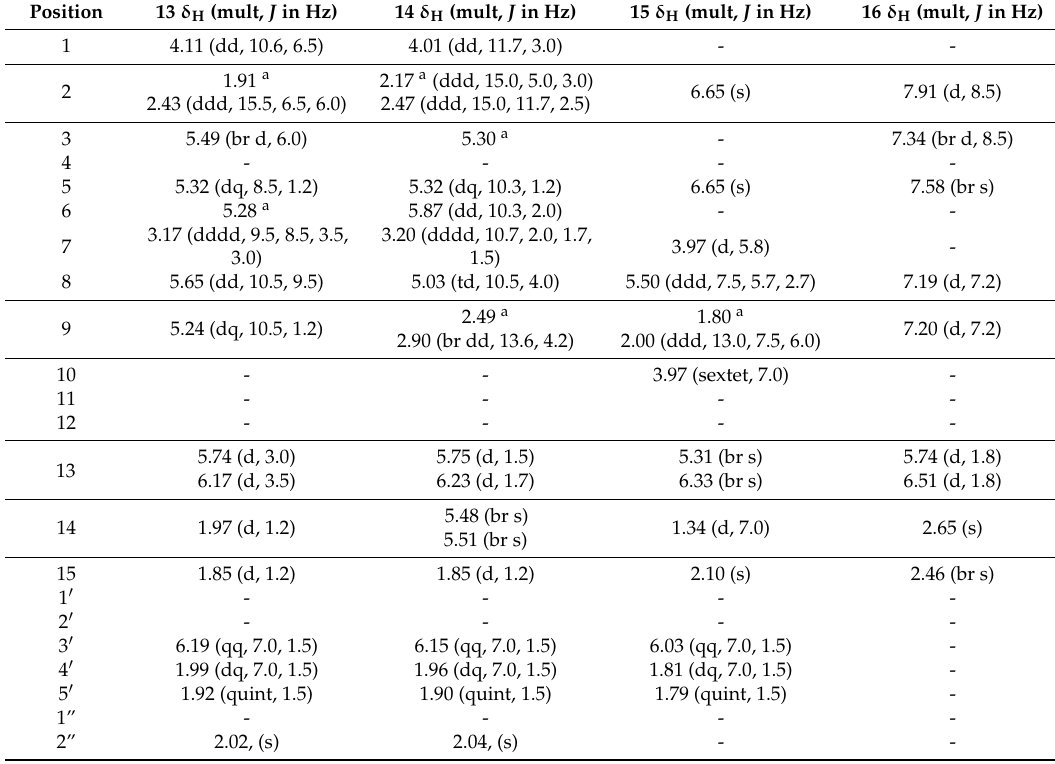
Table 3. 1 H-NMR spectroscopic data for compounds 13 – 16 (CD 3 OD; 500.13 MHz; δ in ppm).